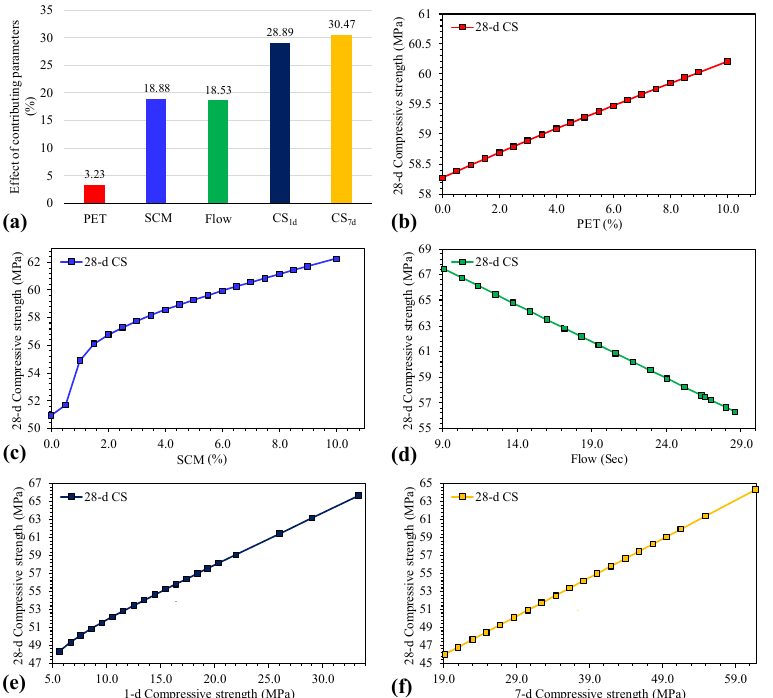
Figure 6. ( a ) Sensitivity analysis and ( b – f ) parametric study of all the considered input parameters (i.e., PET, SCM, Flow, CS 1d , and CS 7d , respectively) .